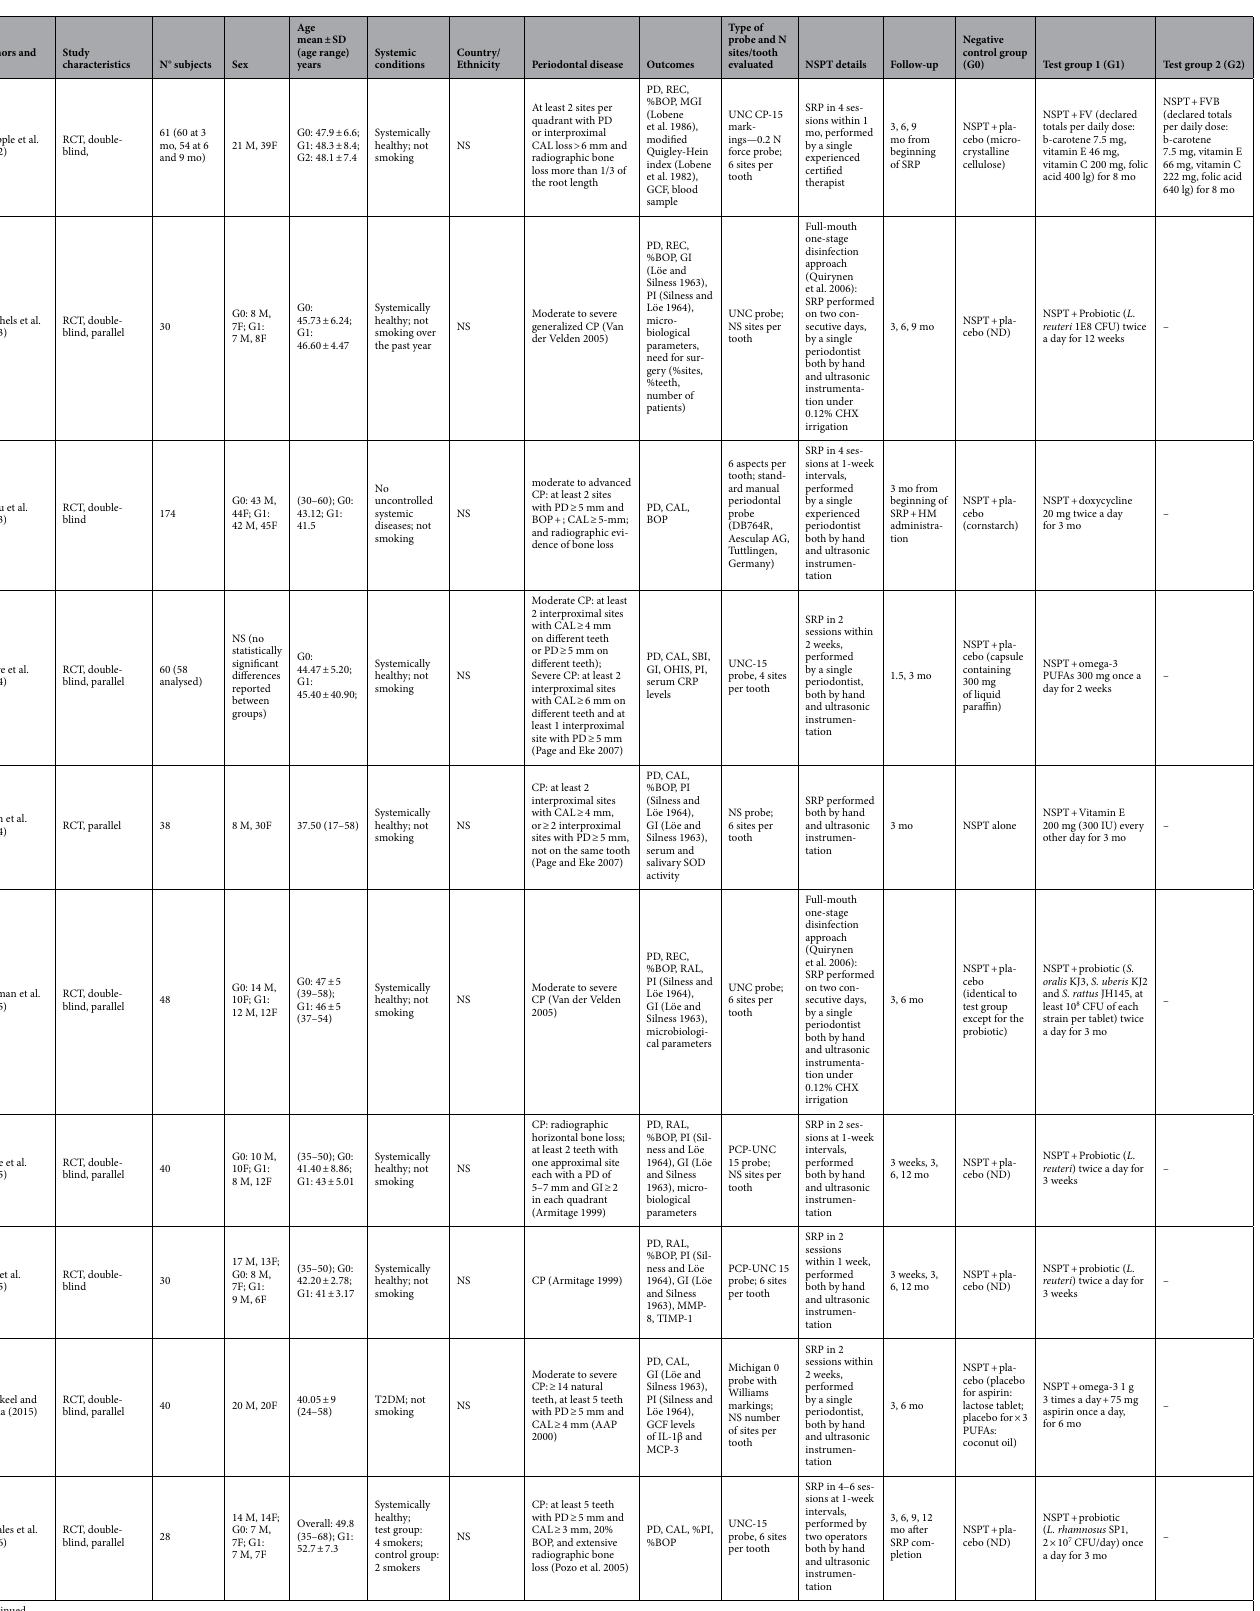
control group: 2 smokers